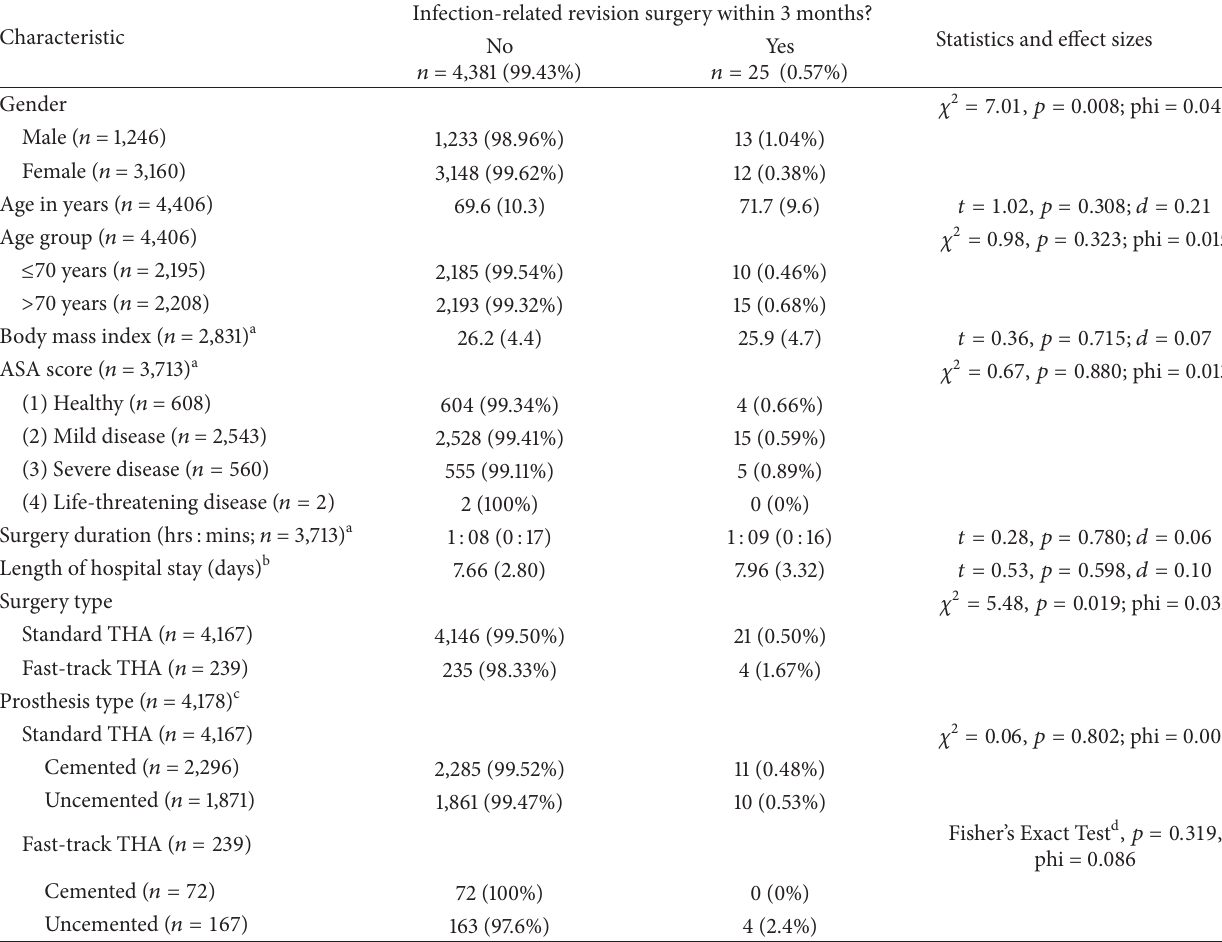
Table 2: Rates of infection-related revision surgery by patient demographic and clinical characteristics ( 𝑛 = 4,406). Characteristic